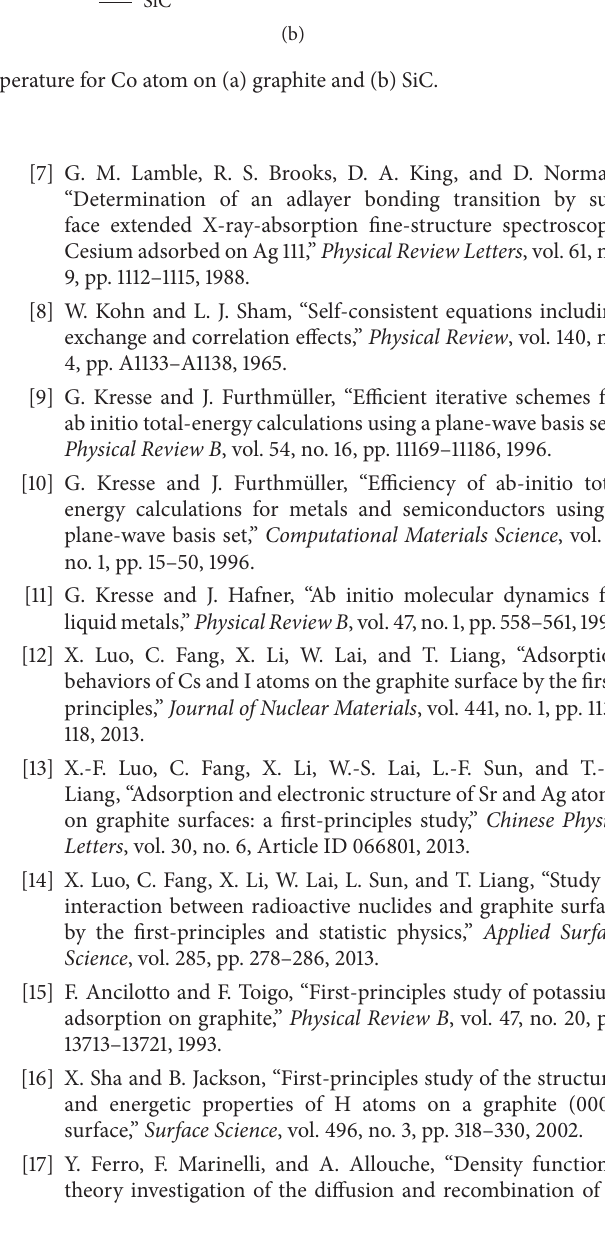
Figure 6: Variation of adsorption ratio with temperature for Co atom on (a) graphite and (b) SiC.